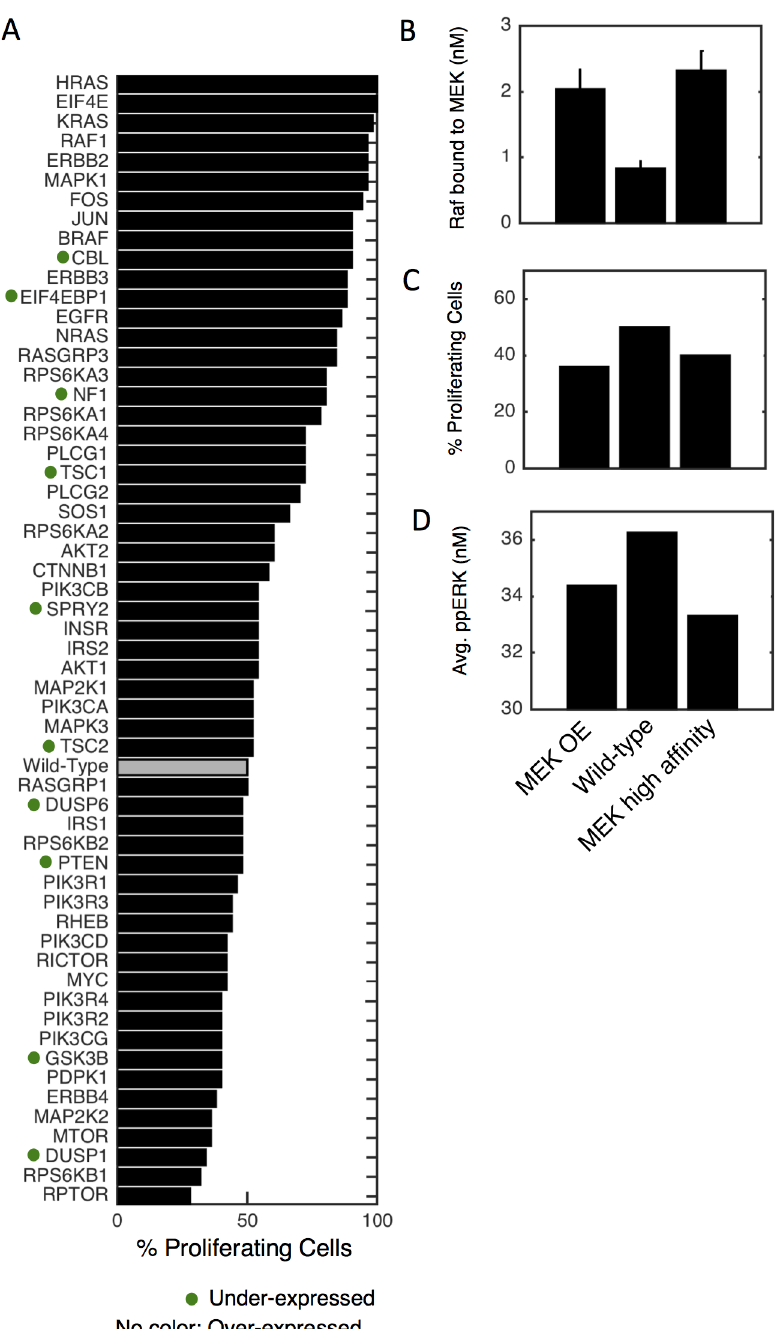
Fig 7. Simulated transformation. A) The mRNA level of each gene is altered 10-fold and EGF + insulin response of starved cells for 24 hours is simulated. Gray bar denotes wild-type, dots denote tumor suppressors (10-fold reduction), and no label denote proto-oncogenes (10-fold increase). B-D) MAP2K2 overexpression (OE-left), wild-type (middle), and MEK-Raf high affinity (right, unphosphorylated MEK has 10-fold higher affinity for all Raf species) were simulated as above and either the level of Raf bound to MEK at t = 0 (B), % proliferating cells (C) or time- averaged ppERK levels (D) were